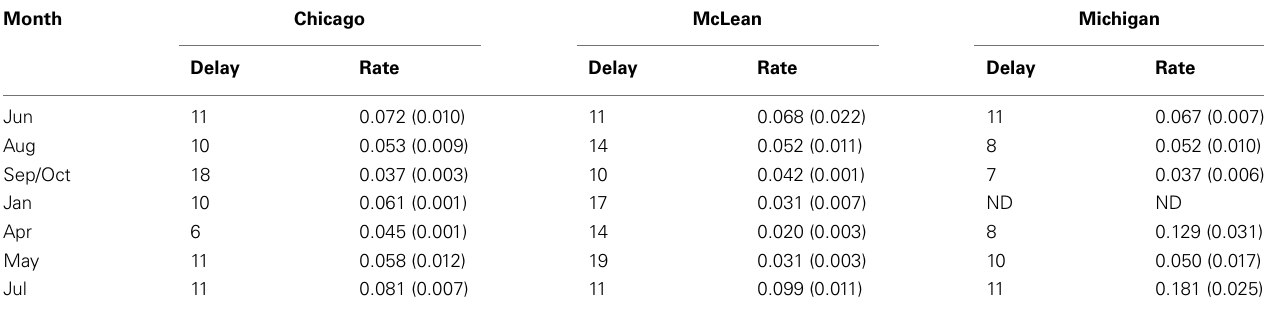
Table 1 | Delay (days) before onset of CH 4 production and rates of potential CH 4 production in peat soils with no added substrates.